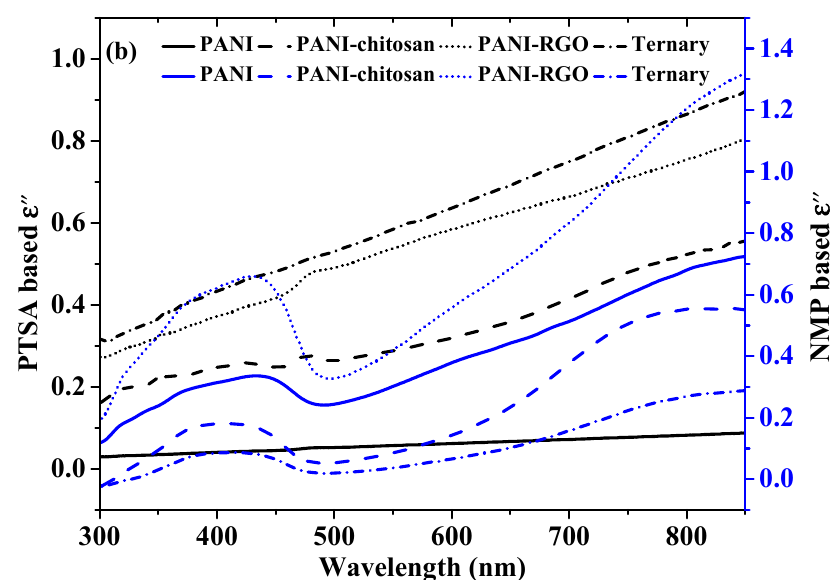
Figure 4. ( a ) Real part dielectric constant of PANI, PANI-chitosan, PANI-RGO and Ternary composites thin layers dispersed in PTSA and NMP ( b ) Imaginary dielectric constant of PANI, PANI-chitosan, PANI-RGO and Ternary composites thin layers dispersed in PTSA and NMP.